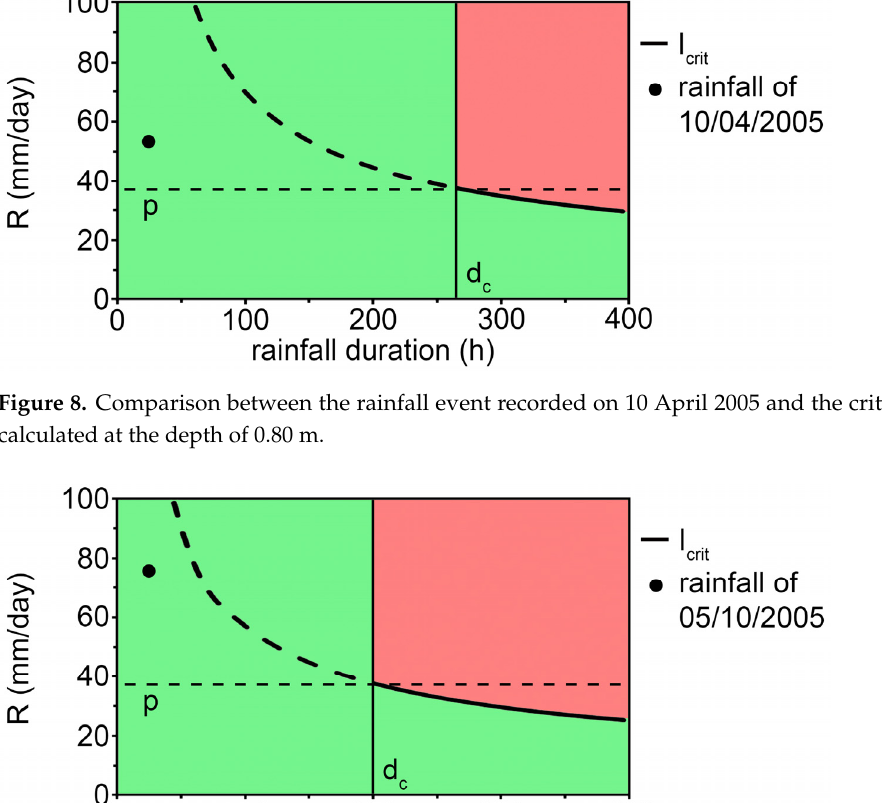
Figure 10. Comparison between the rainfall event recorded on 1 May 2006 and the critical curve calculated at the depth of 0.80 m. By contrast, rainfall totally infiltrates into the slope when the third event is consid- ered ( R < p ). In this case, it also results that d is greater than